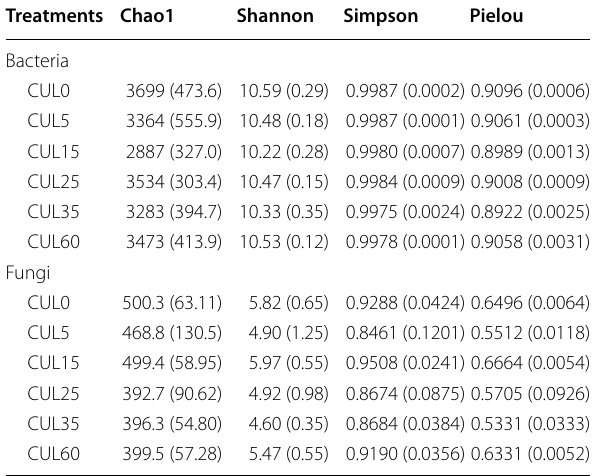
positively correlated with Proteobacteria and Simpson index. Fungal alpha diversity indices and main commu- nity composition at the phylum level were closely linked to BD and SOC, accounting for 13.0% and 10.1% of varia-